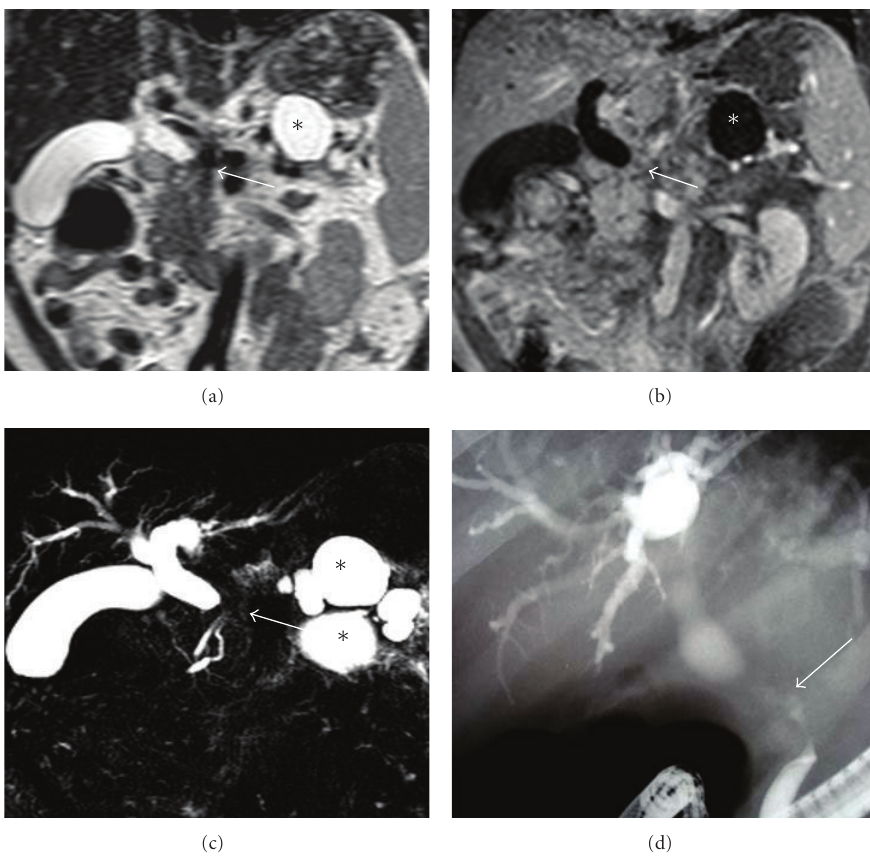
Figure 4: T2-weighted (a), contrast-enhanced T1-weighted MRI (b), and MRCP slices demonstrate significant stenosis in the common bile duct at the level of pancreas head (white arrow) and bile duct dilatation proximal to the stenosis. Any mass lesion is not seen at the stenosis level. On MRI and MRCP, the cause of stenosis considered as chronic pancreatitis because of pseudocysts located in corpus and tail of the pancreas (asterisk). (d) ERCP demonstrates the malignant character of stricture (black arrow), and the result of biopsy was adenocarcinoma of the